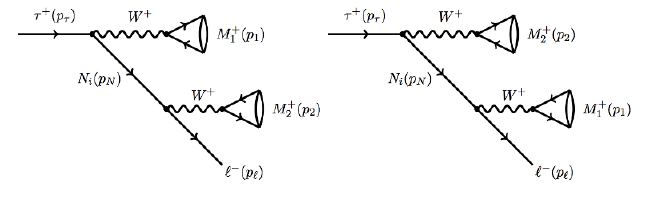
M + ‘ (cid:0) . Left side: direct channel D . 1 2